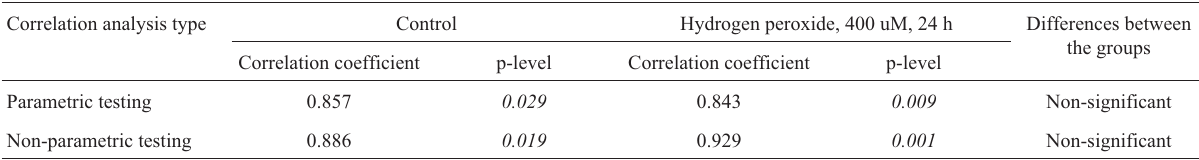
Table 1 - Results of correlation analysis of TBP and POLR2C